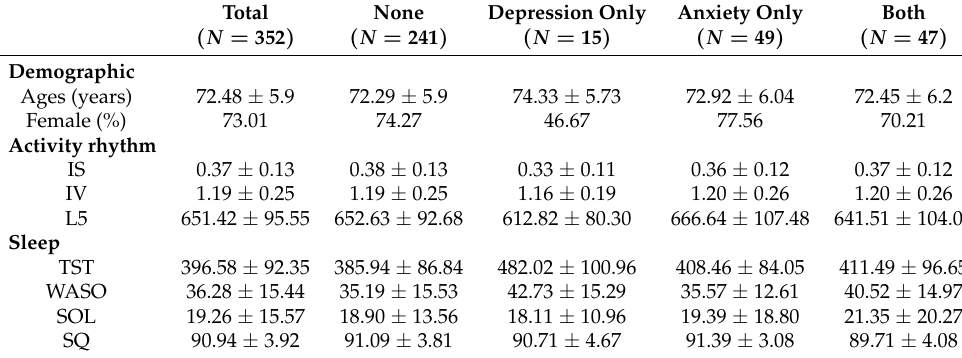
Table 3. Characteristic of Input Features.